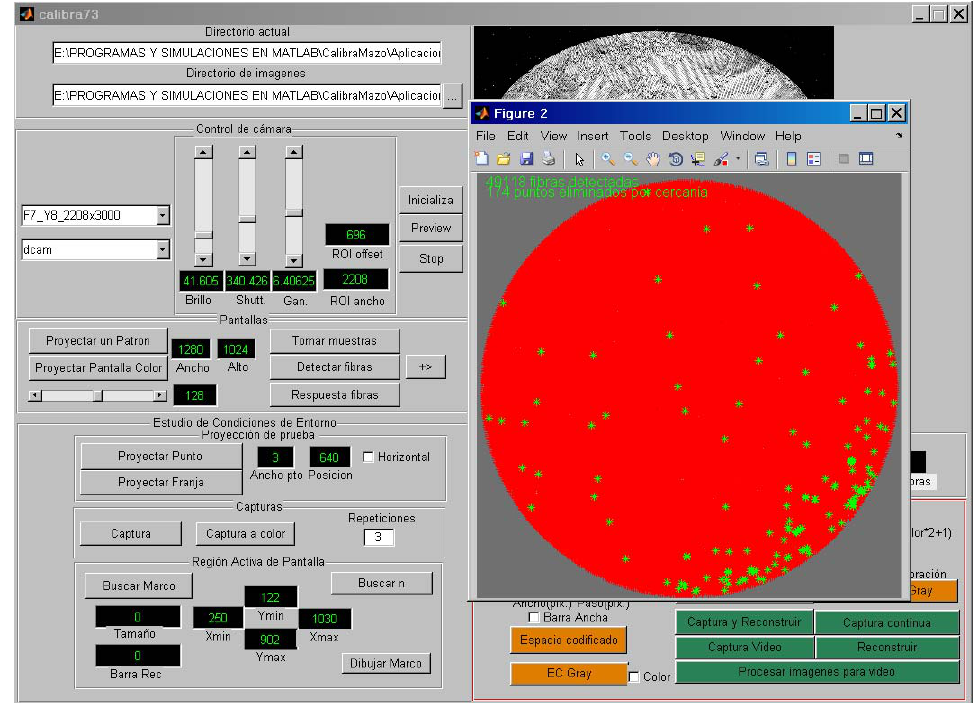
Figure 4. Graphical interface for